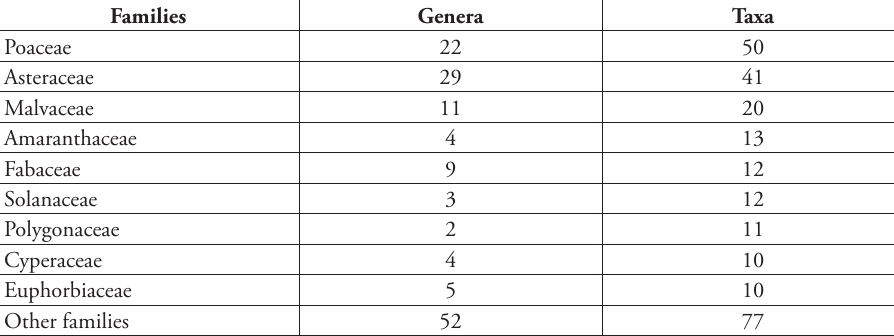
Table 2. Number of genera and taxa in the largest